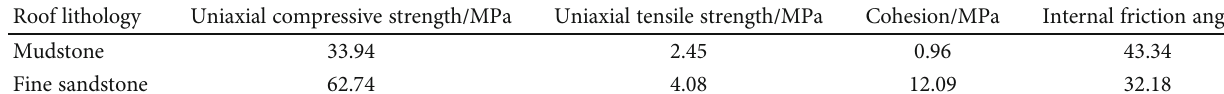
Table 1: Mechanical parameters of roof rock.